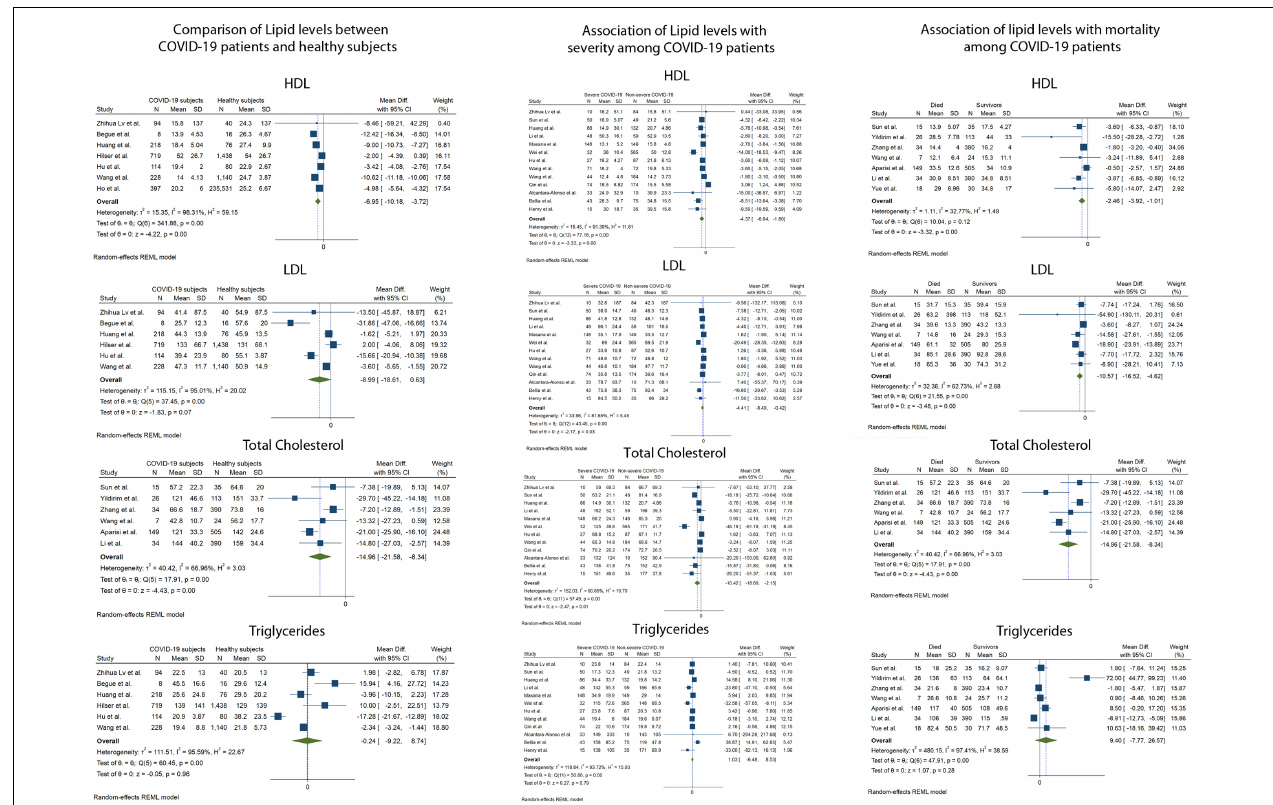
FIGURE 2 | Forest plots showing the random effects meta-analysis for the association of lipid levels with COVID-19 infection, disease severity and mortality. LDL-C, Low density Lipoprotein, HDL-C, High Density Lipoprotein.